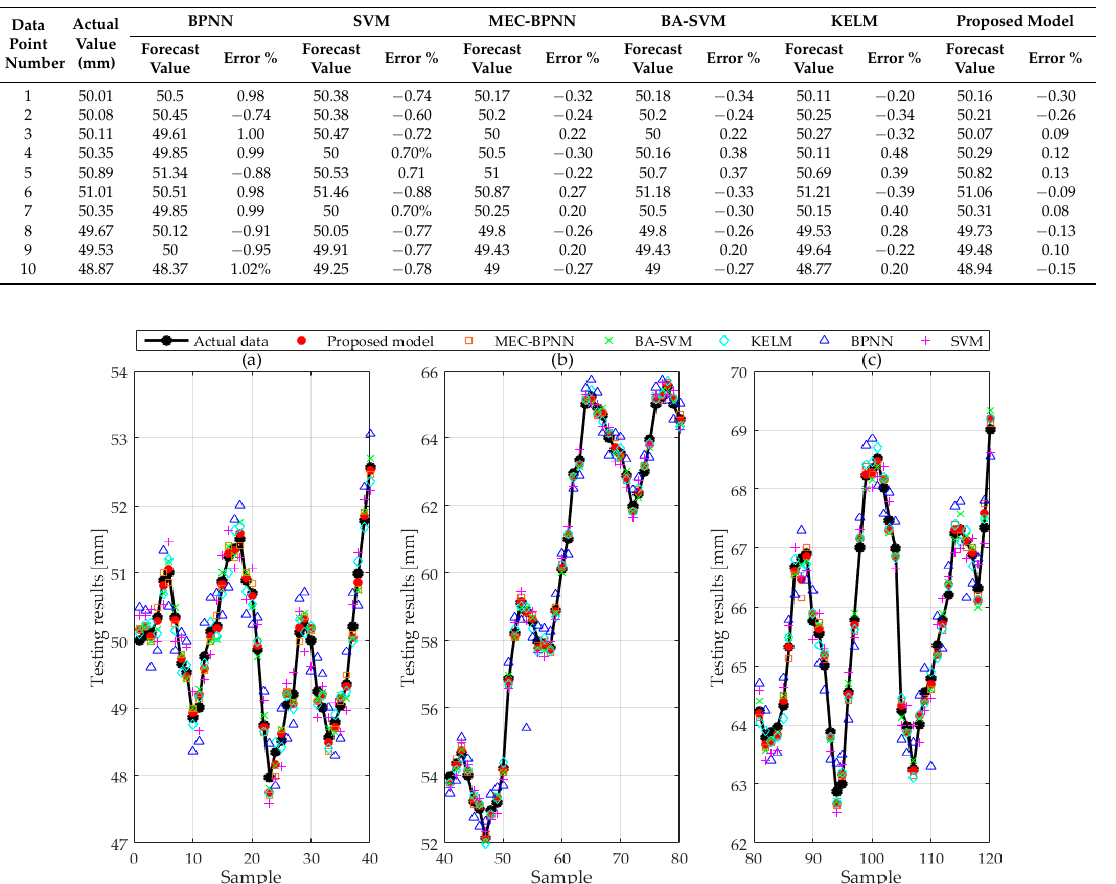
Table 3. Part of the forecasting value and relative errors of each model.